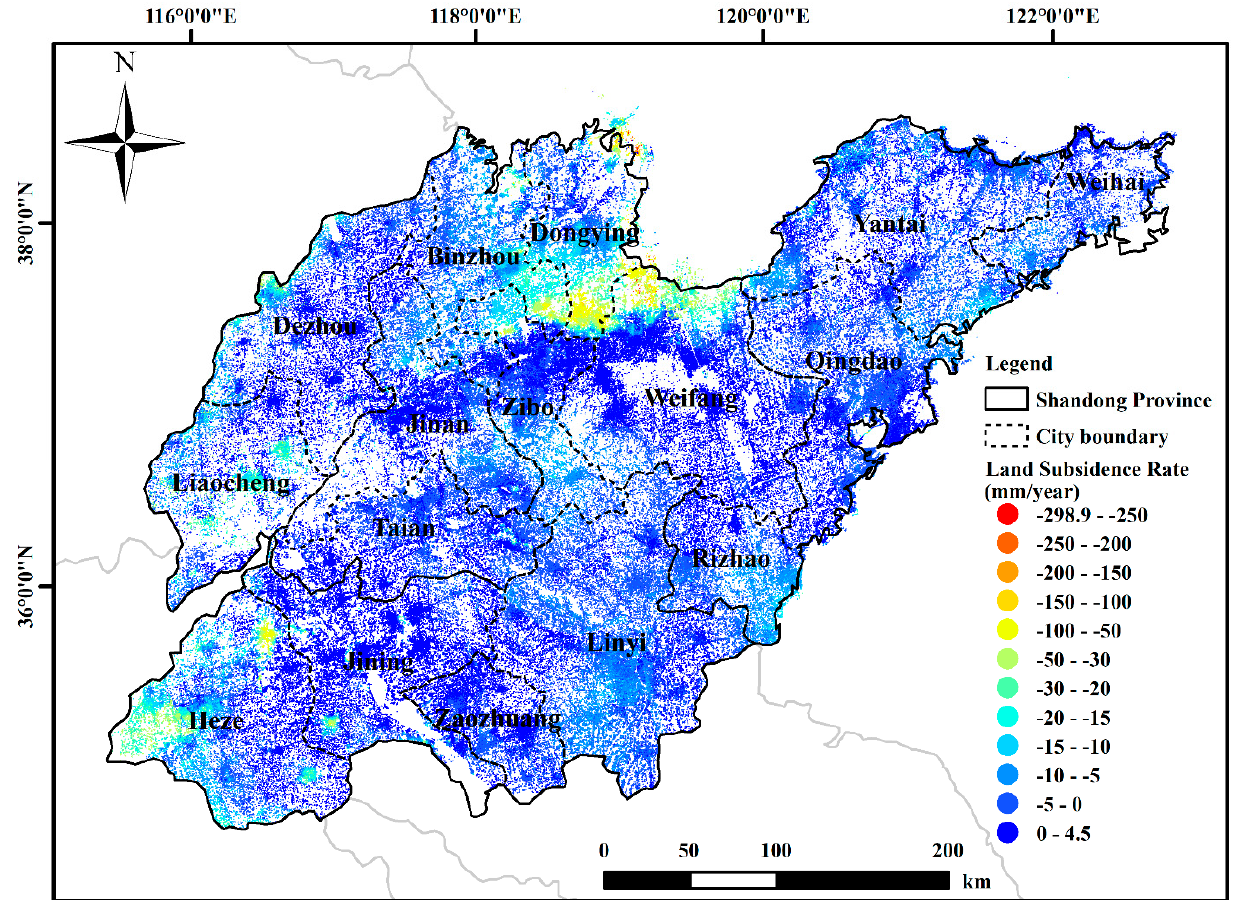
Figure 3. Mean land subsidence rates throughout Shandong Province (SDP) during observation periods between March 2017 and December 2020.